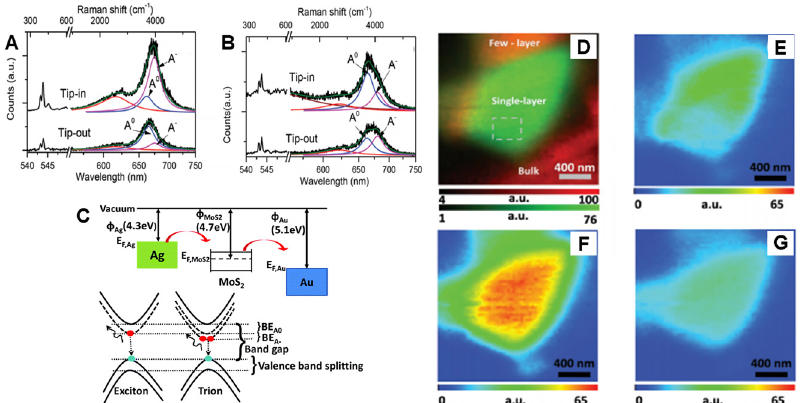
decreased with no peak shift. The other sample was pre- map of B-excitons is shown in Figure 13G. In comparison pared to have both single- and bi-layer fl akes on the sub- with the far- fi eld measurement, PL intensity of trions and strate. Figure 14B and D shows TEPL image and AFM B-exciton are highly enhanced, yet PL quenching behavior topography measured simultaneously. As expected from is shown for A -exciton with TEPL. In addition, far- fi eld PL 0 the difference in electronic band structure of single- and bi- intensity is dominated by the emission of A -exciton, but 0 layer TMDs, strong PL emission was measured only from near- fi eld PL intensity is mainly contributed by trion monolayer fl akes. Additionally, stronger TERS signal was emission. This study nicely demonstrated the local distri- observed from single layer fl akes, as shown in Figure 14C. butions of excitonic components, such as excitons and trions, at the nano-scale with the tip-induced effects.